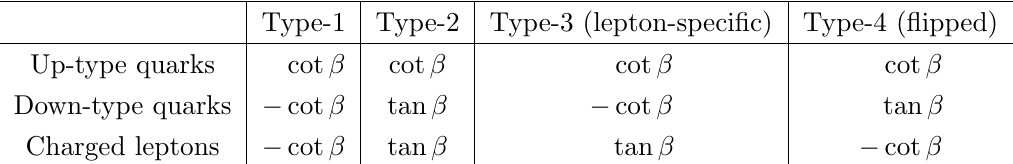
Table 2 . Ratio of the Yukawa couplings of the pseudoscalar boson a of the 2HDM relative to those of the Higgs boson of the SM, in the four types of 2HDM without FCNC at lowest order. (cid:12)eld. Approximate alignment, which is su(cid:14)cient for consistency with LHC data, is